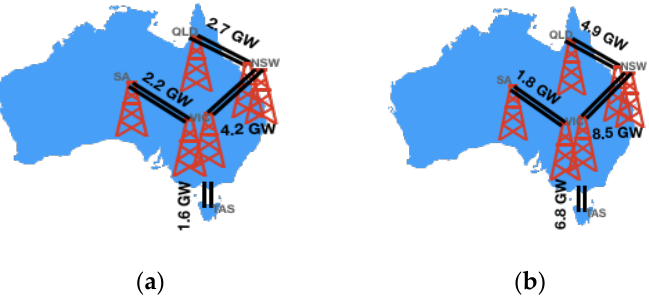
Figure 5. Inter-regional power transmission capacities in P1.5 °C-PVStoCost-High scenario for different years: ( a ) 2030; ( b ) 2050.